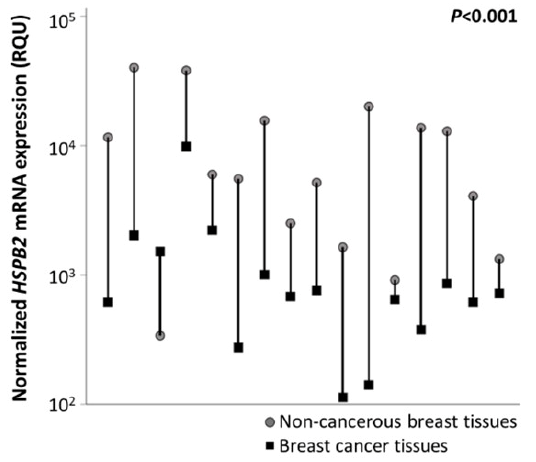
Figure 2. Graphical illustration of HSPB2 mRNA expression levels in cancerous vs. non-cancerous tissues, after comparing 16 pairs of tissue specimens. The HSPB2 mRNA expression levels were downregulated, as compared to normal adjacent tissues, in almost all tumors. p -value was calculated by the Wilcoxon signed-rank